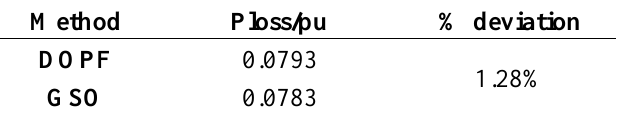
Table 9. Comparison of results between two methods.